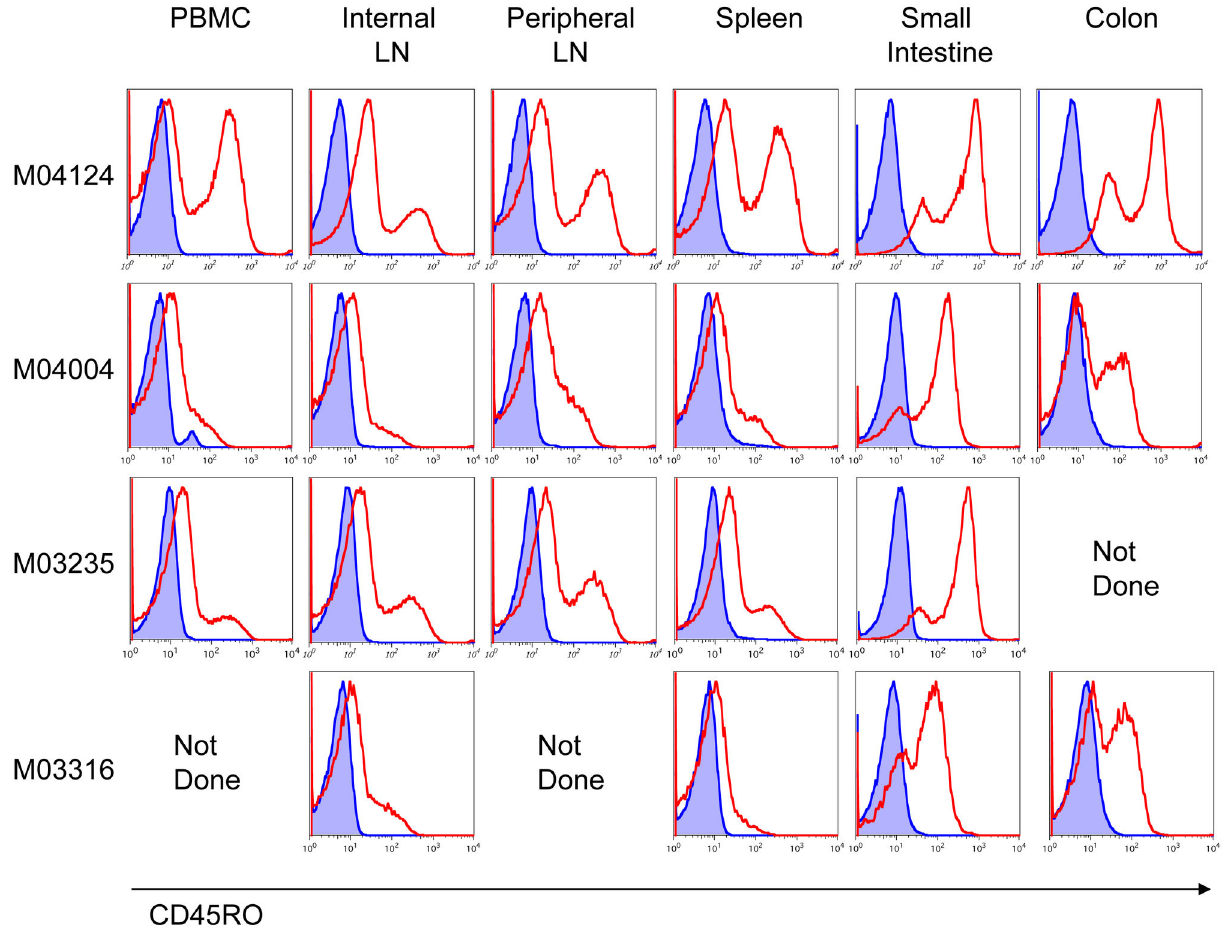
Figure 6. CD45RO on T-cells isolated from tissue. Lymphocytes were isolated from tissue explants taken at the time of necropsy from one uninfected (M04004) and three aviremic SHIV-infected pigtailed macaques. Lymphocytes were pooled from the mesenteric and bronchial lymph nodes (internal LN) and from the axillary and inguinal lymph nodes (peripheral LN). Cells were then stained with Abs to CD3, CD4, CD8, and CD45RO and analyzed by flow cytometry. Acquired cells were gated on lymphocytes by light scatter, and then on CD3+ cells. Stained cells are shown in red. Unstained controls are shown in blue. Data representative of n=5-6